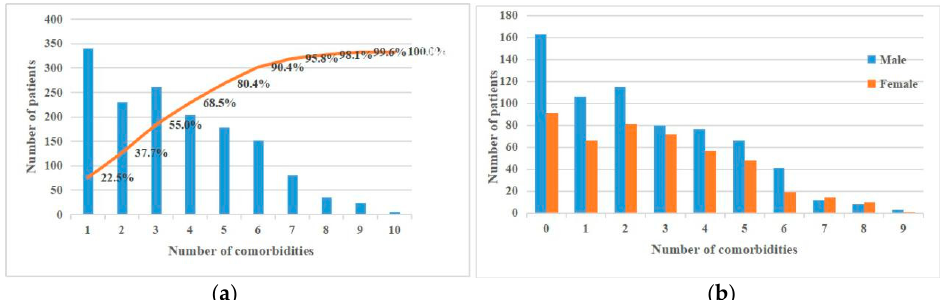
Figure 1. ( a ) Distribution (blue) of the number of comorbidities across all patients, where the x-axis represents the number of patients having n comorbidities (0 ≤ n ≤ 9) and the cumulative proportion distribution across all patients (orange). ( b ) Distributions of the numbers of comorbidities for men and women.